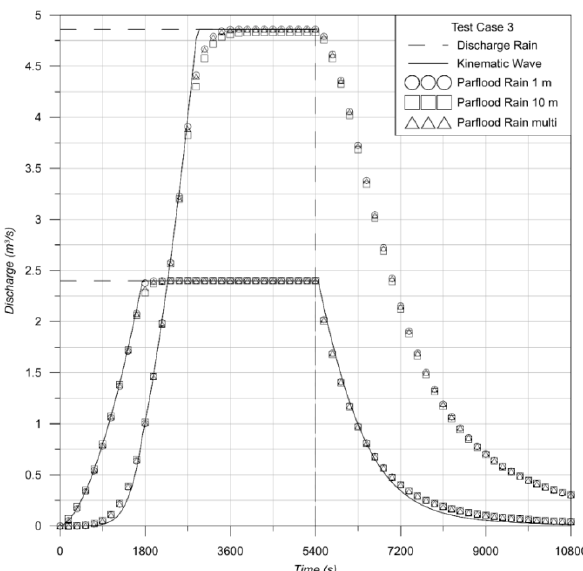
Figure 7. Hydrographs at the end of each hillside and at the channel outlet for different configurations